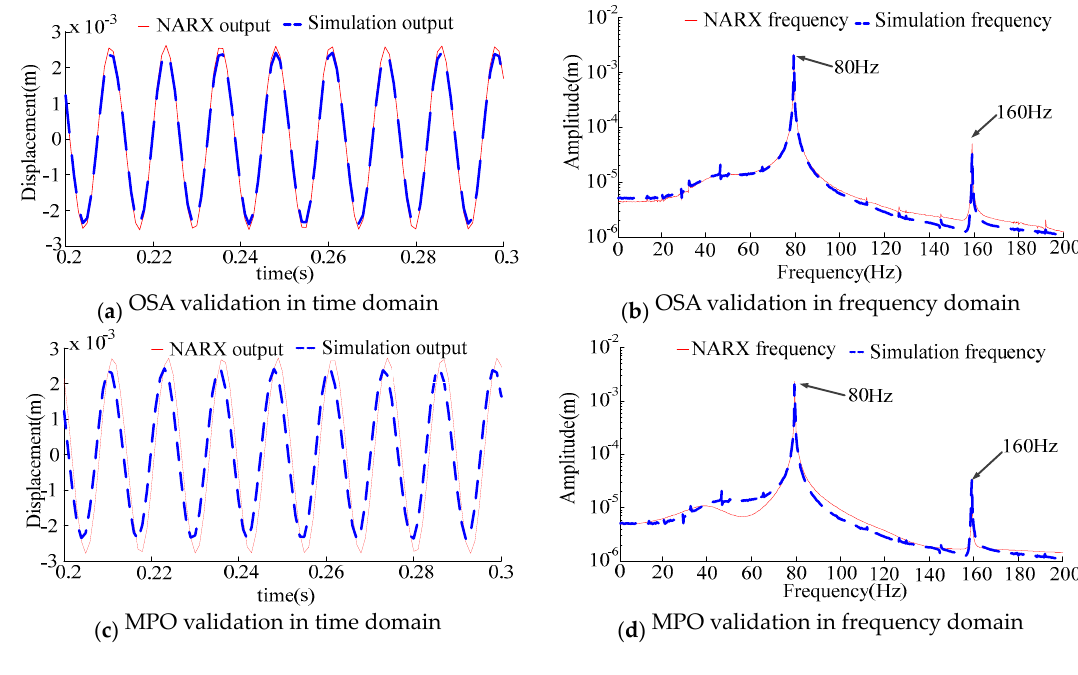
Figure 8. Output comparison in time and frequency domain when ω = 500 rad/s. Table 2. Root square mean error (RMSE) of MPO and OSA method in a large frequency range. Frequency Range (rad/s) RMSE of MPO Method (m) Frequency Range